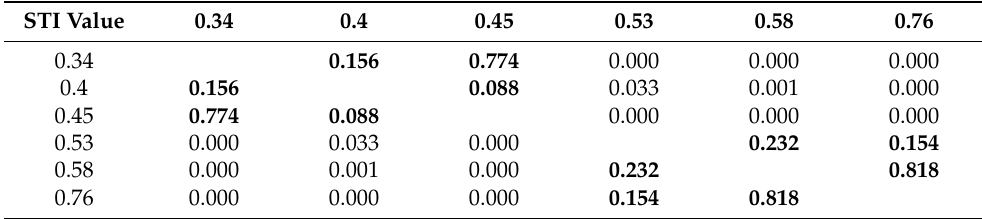
Table 5. Matrix of p -values obtained after carrying out Dunn’s post hoc test for the optimal RoS value. Statistically insignificant values are marked with a gray background.